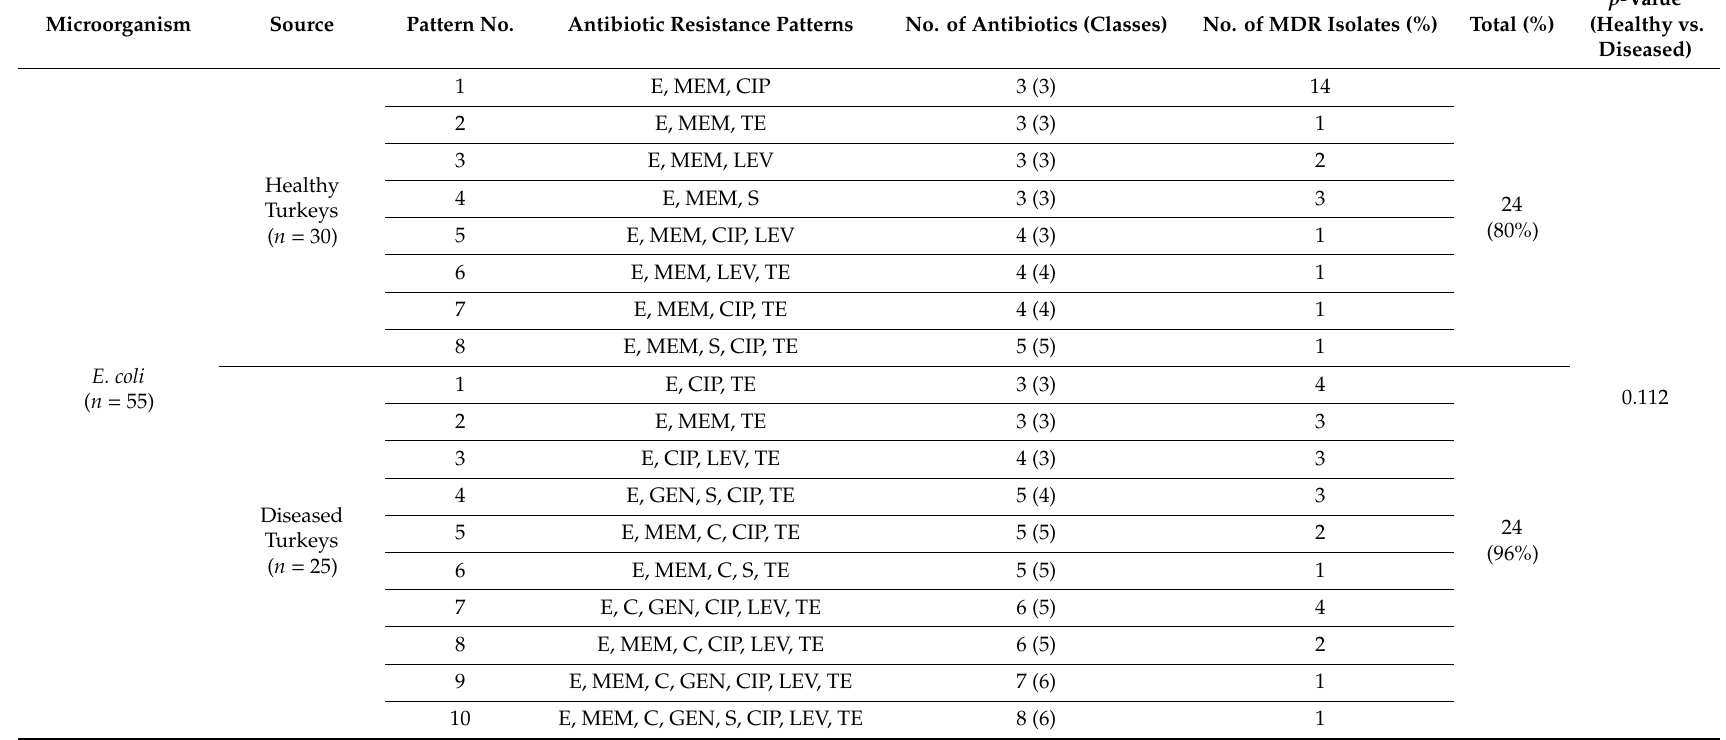
Table 2. Multidrug resistance profiles of E. coli and Salmonella spp. isolated from healthy and diseased turkeys. Microorganism Source Pattern No. Antibiotic Resistance Patterns No. of Antibiotics (Classes) No. of MDR Isolates (%) Total (%)